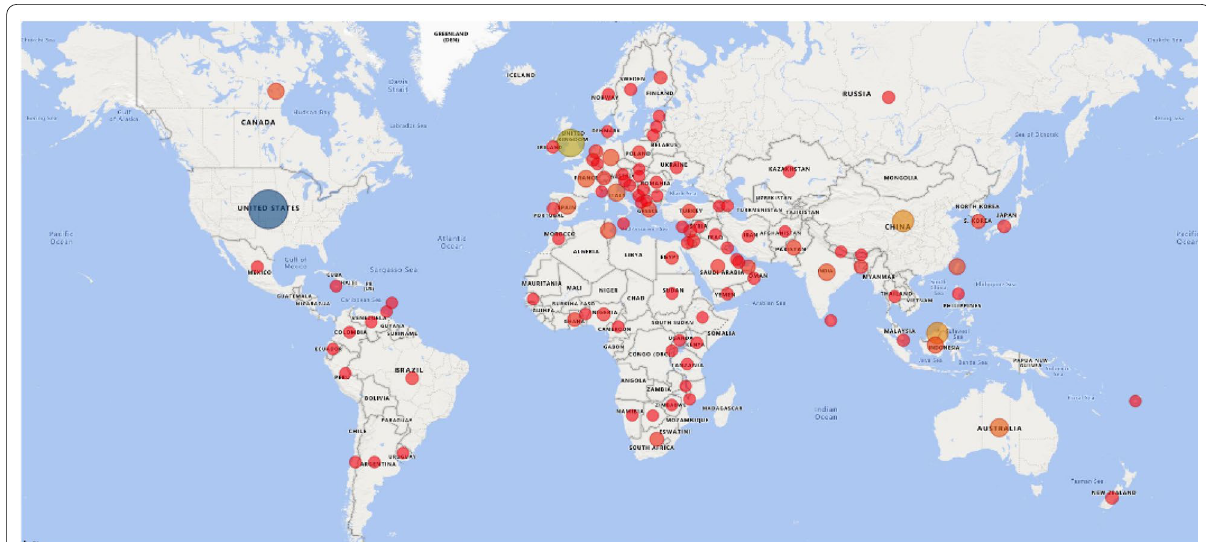
Fig. 5 Location of articles published on Triad of profitability, regulation, and risk